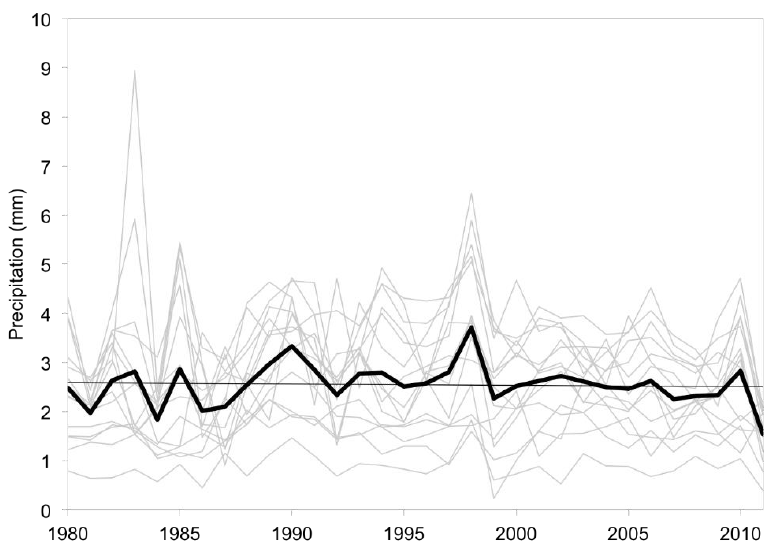
across all provinces.